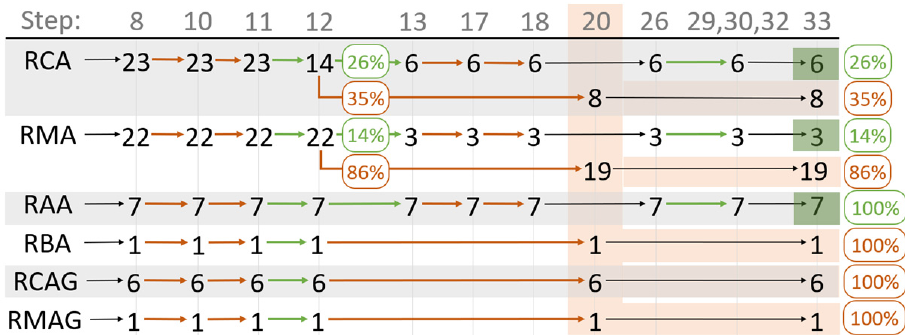
Figure 2. Quantitative methodology application flow by RA type (each cell represents the quantity of RA in each step of the methodology, orange arrows correspond to option “no”, green arrows correspond to option “yes”, orange cells correspond to “material may represent a toxicity concern level” and green cells correspond to “acceptable toxicity risk level”).